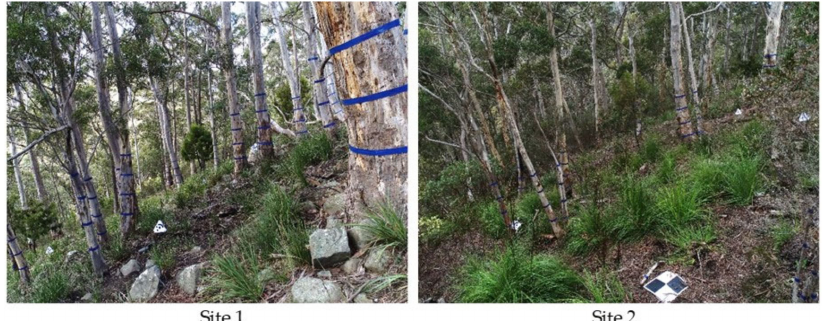
Figure 3. ( Left ) Site 1 had a stem density of 885 stems per hectare and under-story vegetation of approximately 0.5 m tall. ( Right ) Site 2 had a stem density of 980 stems per hectare and under-story vegetation of up to 2.5 m tall.